Question: In one sentence, what is this figure communicating?
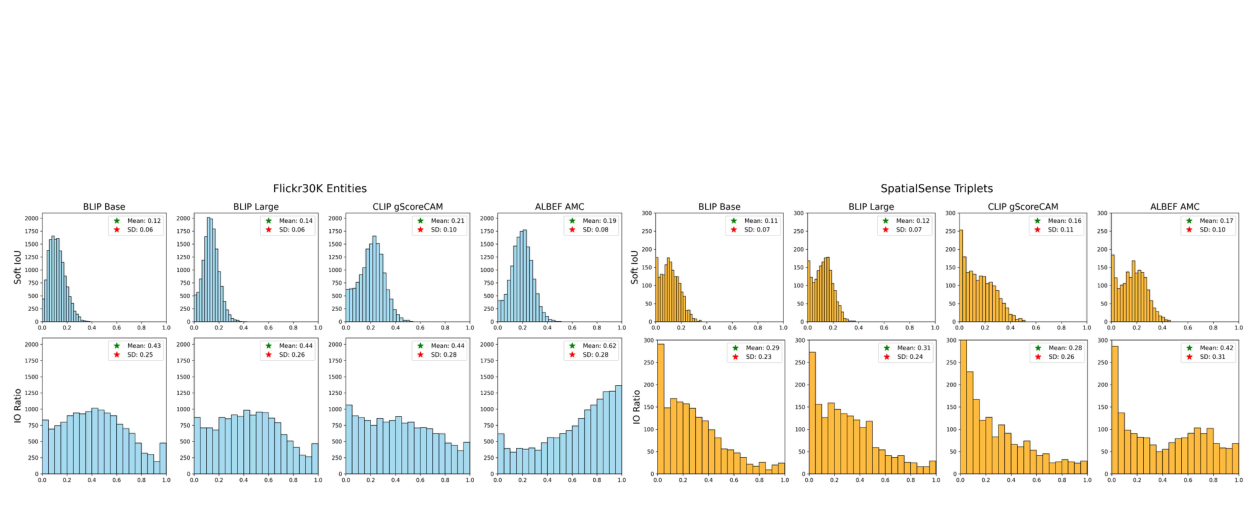
Answer: Histogram of IoUSoft and IOratio distributions for ID vs. OOD. Note that the histograms are more peaked for in-distribution datasets, as shown in blue on the left, and for better-performing models, they are shifted to the right. The out-of-distribution experiments for all models have less peaked, flatter histograms, where shown in orange on the right. Full visualizations can be found in Appendix 8.